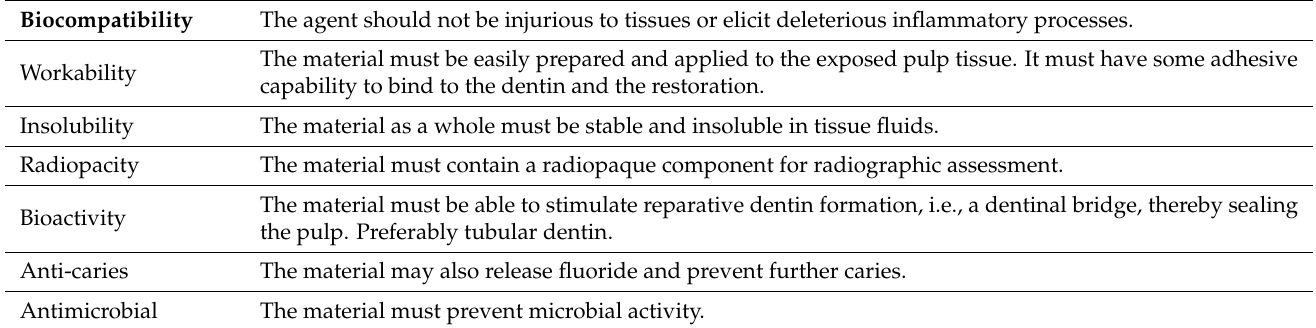
Table 1. The ideal qualities of pulp-capping